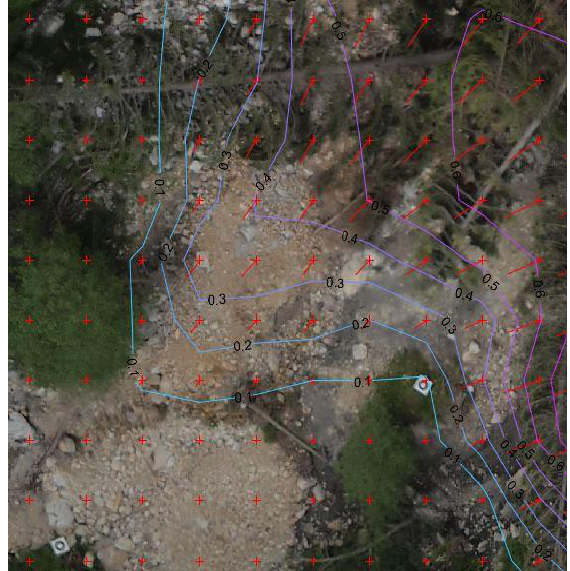
Figure 5. Displacement vector candidates prior to filtering. Generally we place ground control points on the same positions for each of the consecutive measurements, therefore most false matches are found at ground control points.